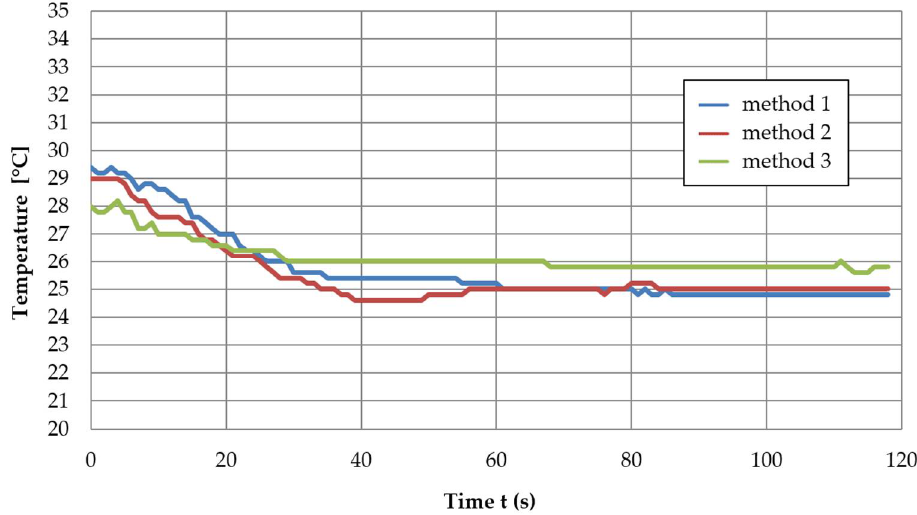
Figure 9. Comparison of control methods for the water cooling condition in terms of average temperature in time.